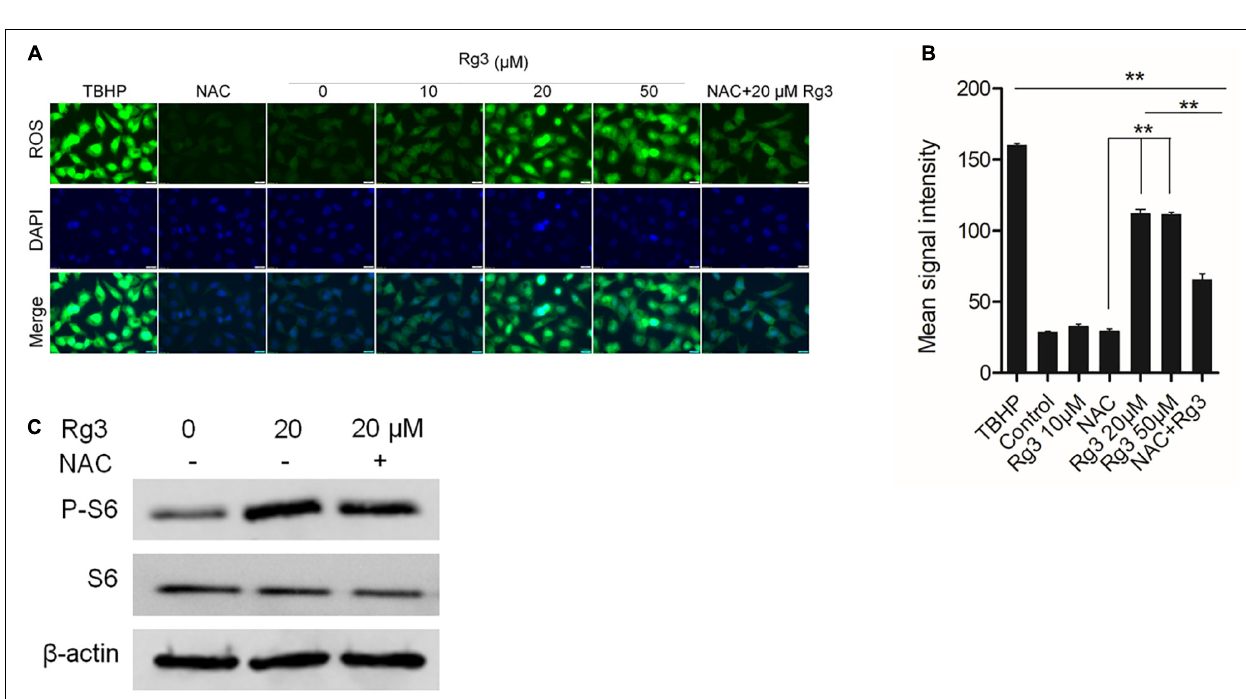
FIGURE 3 | Rg3 attenuates dephosphorylation of S6 upon serum withdrawal. (A) Cells were treated with Rg3 (A) or vehicle control (B) for 30 min followed by serum withdrawal. The levels of phosphorylated S6 and total S6 at indicated time points after the serum withdrawal were determined by Western blotting.